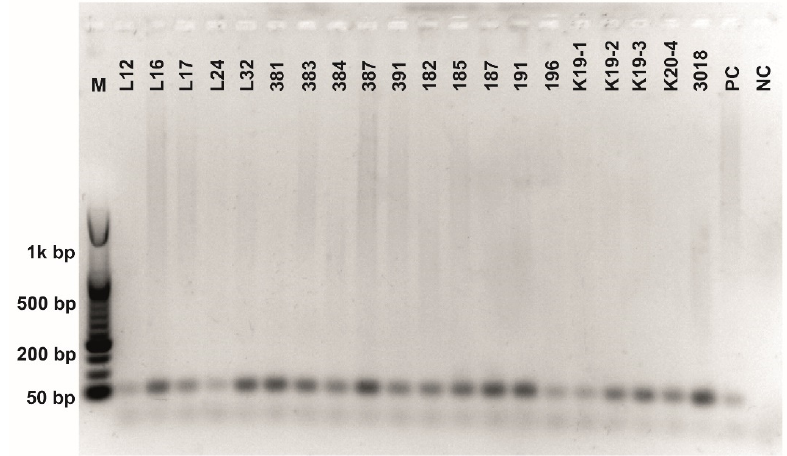
Figure A3. Class 2a bacteriocin gene belonging to the Clade 1 amplification. O’RangeRuler TM 50 bp DNA Ladder was used as a molecular marker. PC-positive control by strain ATTCC 14917.